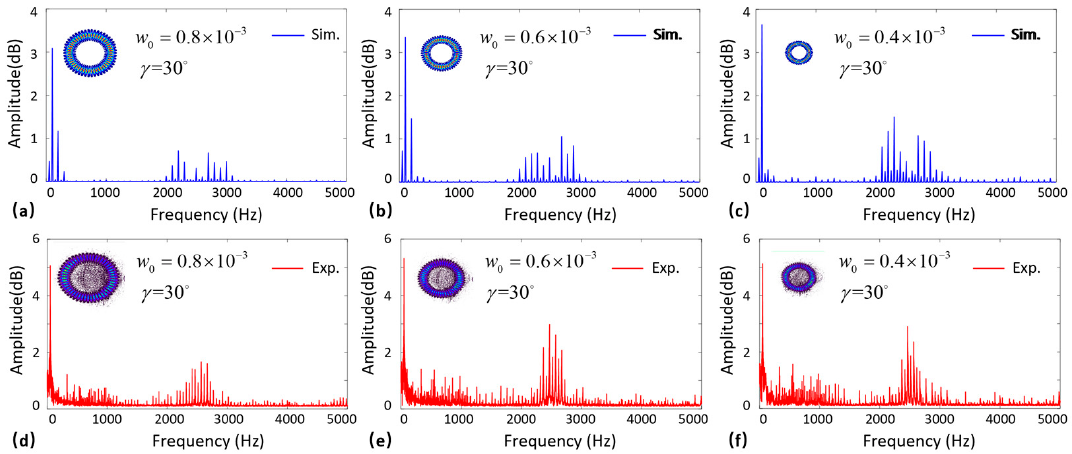
Figure 6. Simulated and experimental results under light oblique incidence. ( a – c ) Simulated results